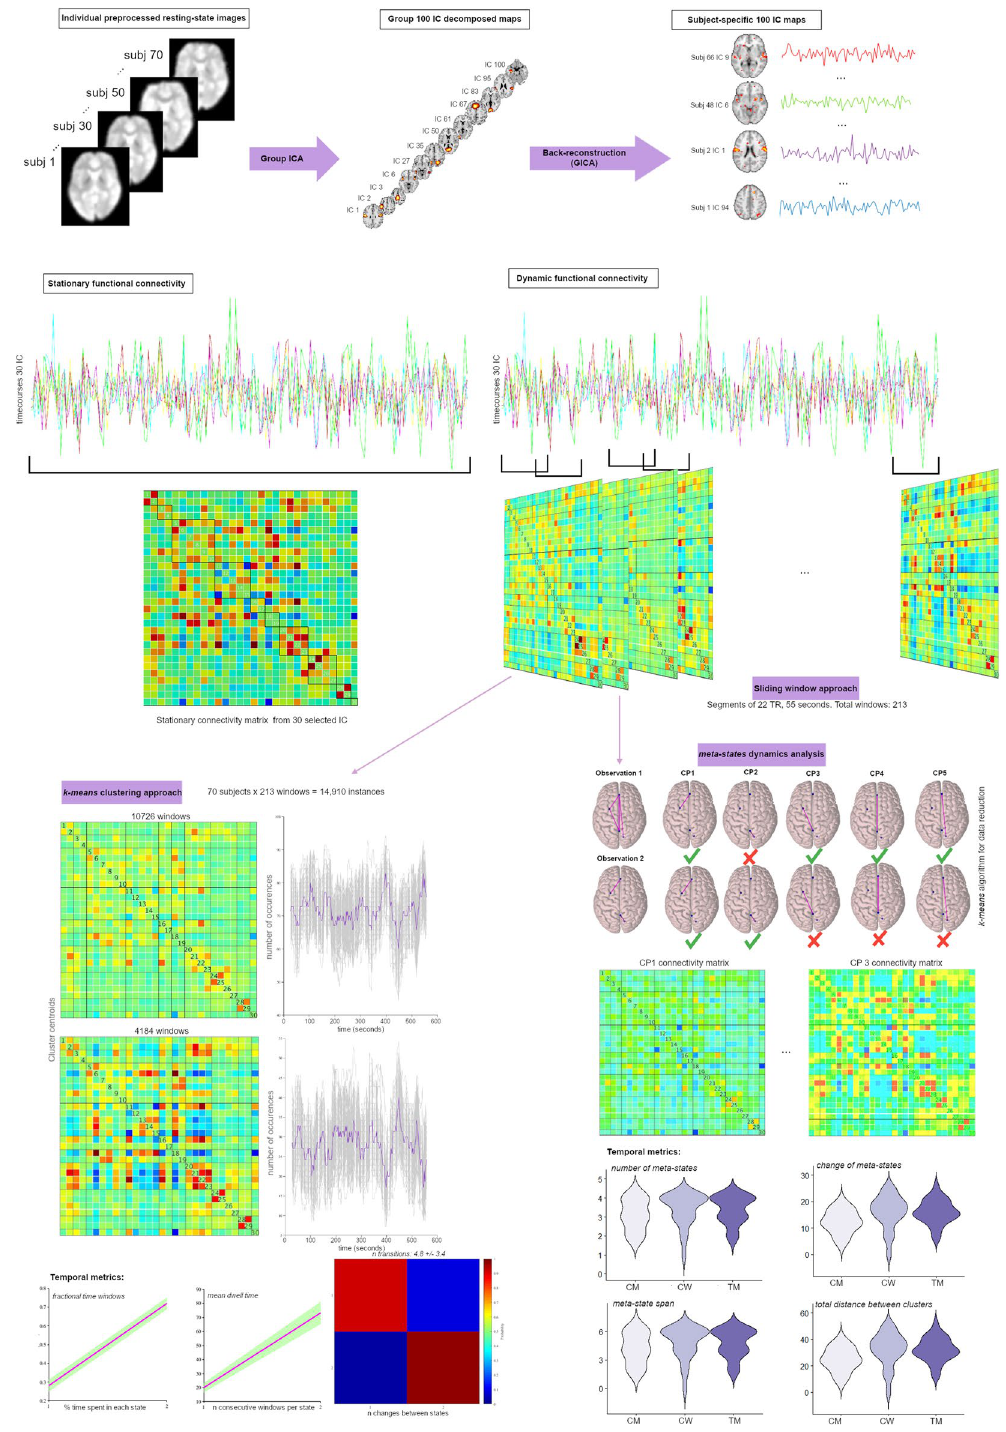
Figure 1. Summary of analyses steps. Group independent components (IC) analysis decomposes resting-state data of the total 70 subjects into 100 IC components. GICA back-reconstruction is used to estimate subject-specific IC maps and time courses. From the stationary functional connectivity (FC) maps, subject-specific time courses were segmented into 55 s (22 TRs) and moved by 1 TR (2.5 s) = 213 windows. These windows were used to calculate the FC covariance matrices using the sliding window approach. Secondly, these matrices (per subject) were used to classify FC into clustered FC patterns (states) using a k-means clustering approach. From this technique, we obtained temporal metrics such as fractional time windows, the mean of the dwell time per state and number of transitions. Finally, we applied the meta-state dynamic method that models the windowed FC time courses from the sliding window approach as weighted sums of maximally independent connectivity patterns (CP) 30 . Each CP is recast as a discretized vector of CP weights called meta-state. We used a k-means clustering algorithm for data reduction. We obtained the following metrics: number of meta-states, change of meta-states, meta-state span and total distance between clusters (i.e., CP). The Surf Ice software (https:// www. nitrc. org/ proje cts/ surfi ce/) was used to plot the brains, and connectivity matrices were extracted from Matlab R2020b (The MathWorks, Inc., Natick,